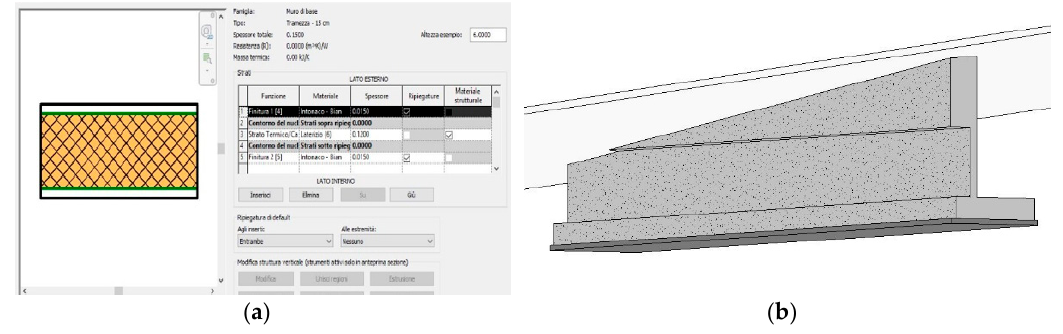
Figure 11. Modeling Retaining walls using Revit: ( a ) wall family; ( b ) overlapping wall.